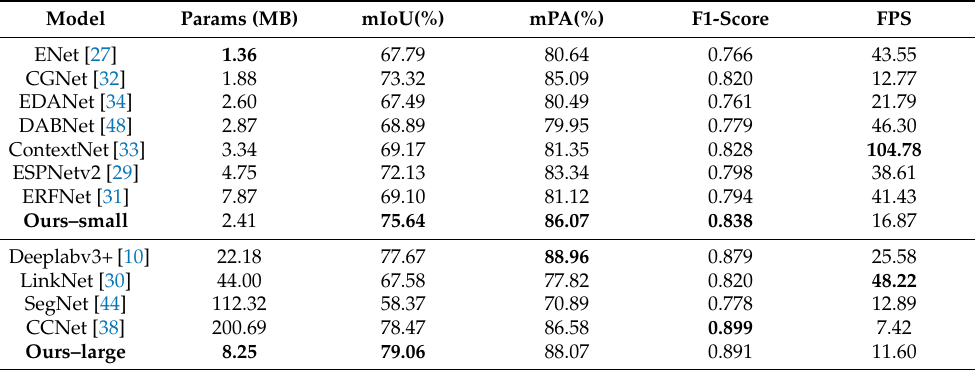
Table 2. Comparison between our model and other SOTA image segmentation methods.